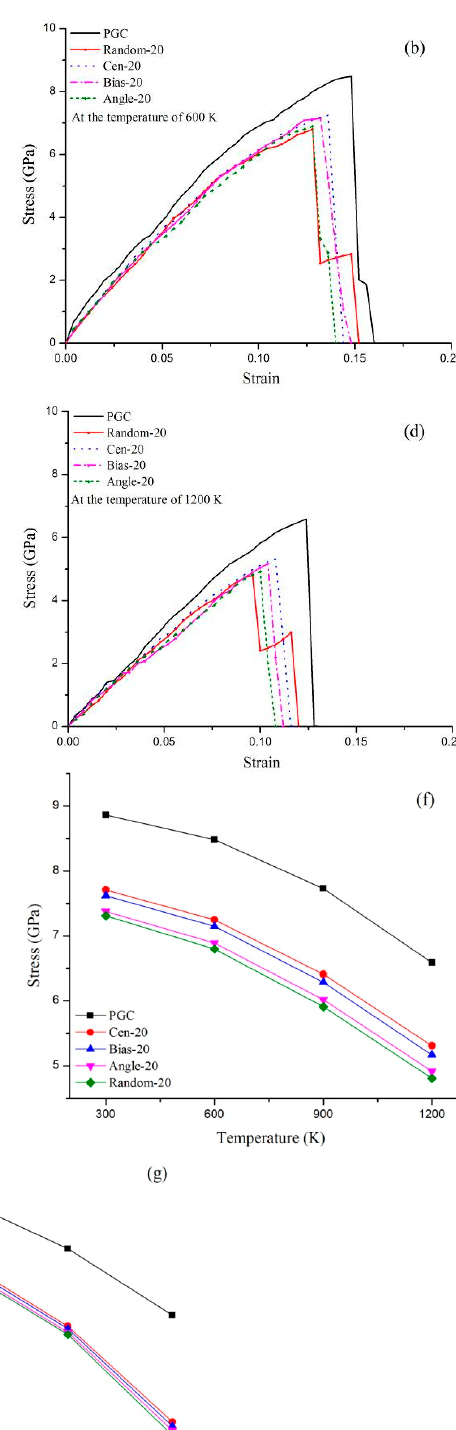
are induced by 20 randomly ions irradiation. ( b ) Block corner, ( c ) eccentric line, and ( d ) centerline